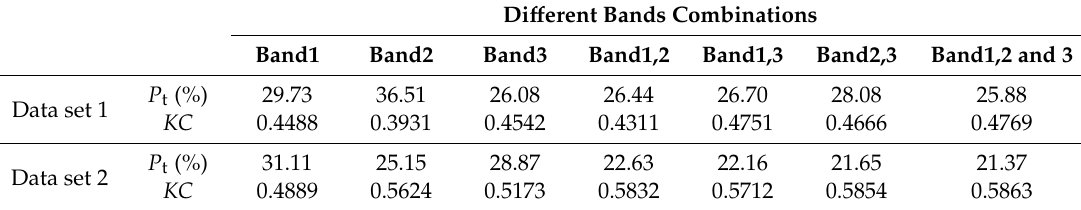
Table 3. The accuracy of change detection generated by change vector analysis (CVA) with di ff erent bands